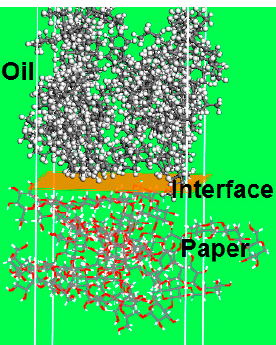
Figure 13. Simulated conformation of oil and cellulose molecules in the cellulose amorphous region at an oil-paper interface. an oil-paper